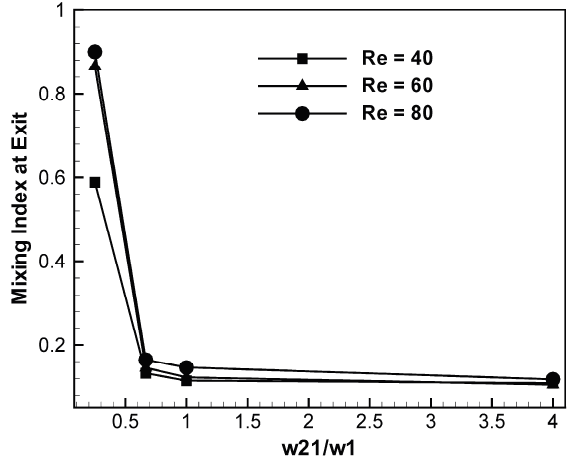
Figure 12. Effect of width of minor sub-channel 1 ( w 21 ) on mixing in the three-split micromixer for various Reynolds